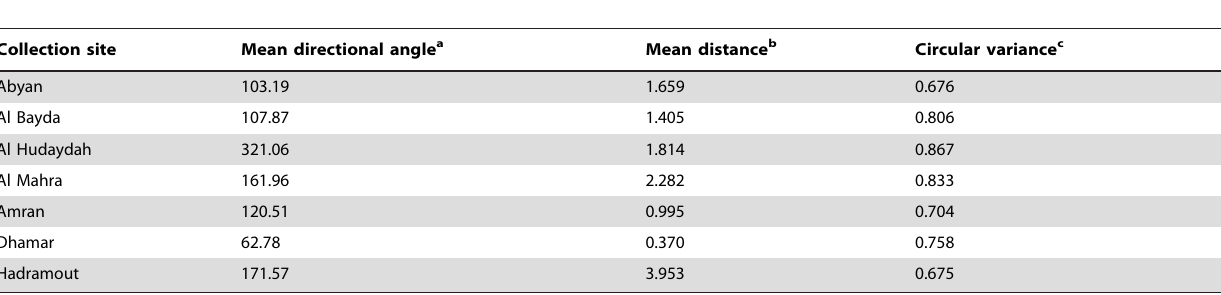
Table 3. Estimates for the direction of migration in each collection site across all three generation groups.